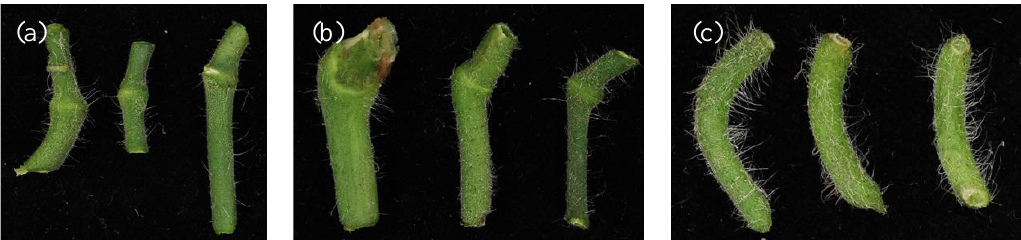
Figure 2. Categories of fruit pedicel abscission zones. Categories were assigned according to their visibility and function as breaking point for the pedicel at harvest. ( a ) 1: Visible and functional; ( b ) 2: Present and visible but less functional; and, ( c ) 3: No visible abscission zone.